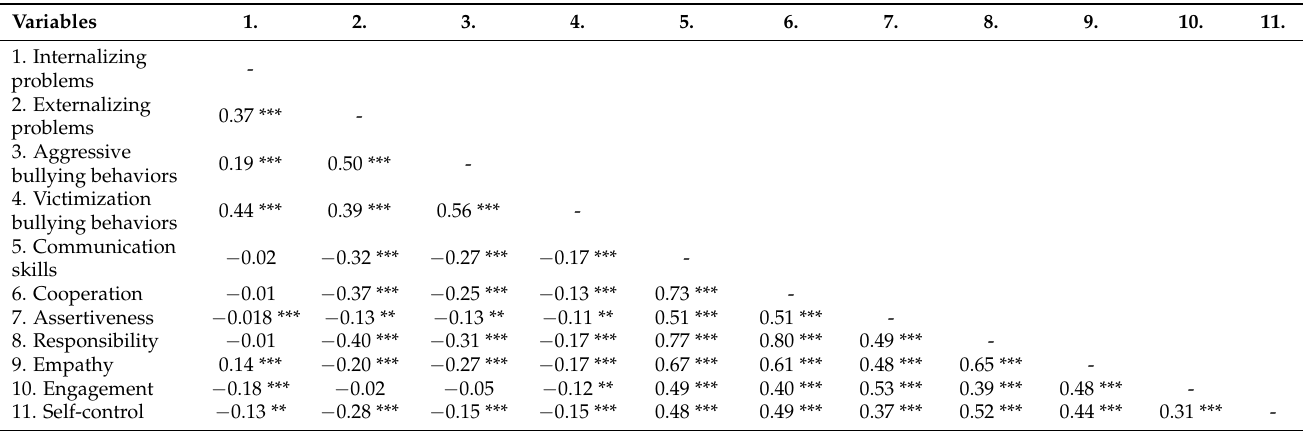
Table 2. Pearson’s correlation coefficients between internalizing and externalizing problems, aggressive and victimization bullying behaviors, and social skills (N =